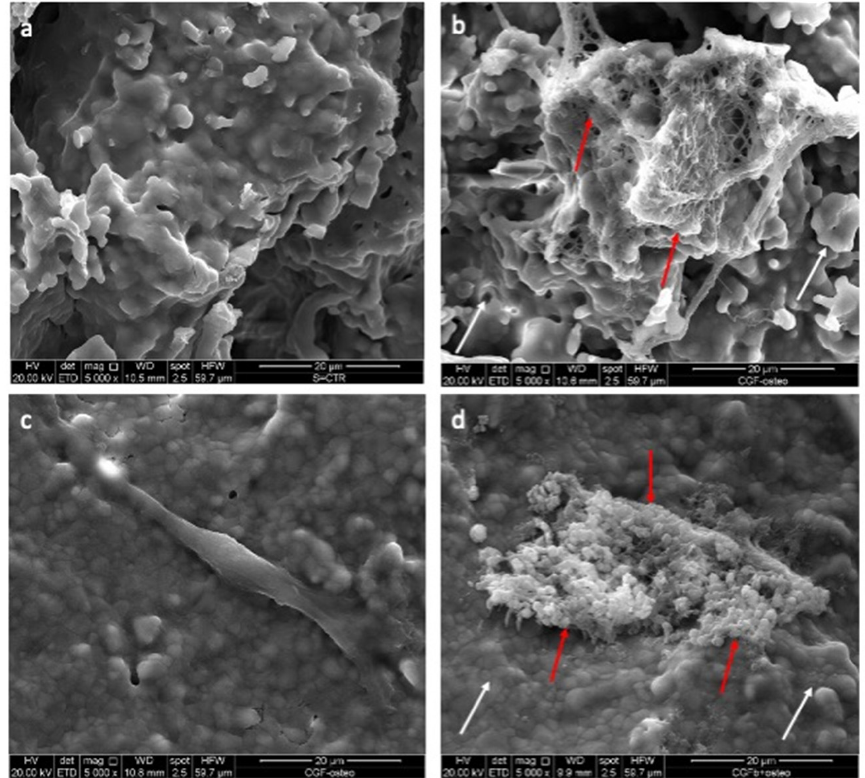
Figure 6. SEM images of CGF primary cells seeded on HA-Si scaffolds (scale bar = 20 µ m). ( a ) HA-Si scaffold; ( b ) HA-Si scaffold cultured with CGF in BM for 21 days; ( c ) Cell released from CGF in BM for 21 days and adhered on HA-Si scaffold; ( d ) HA-Si scaffold cultured with CGF in OM for 21 days. White arrows indicate the HA-Si scaffold surface, red arrows indicate the mineralized structure formed by CGF primary cells after 21 days of incubation.